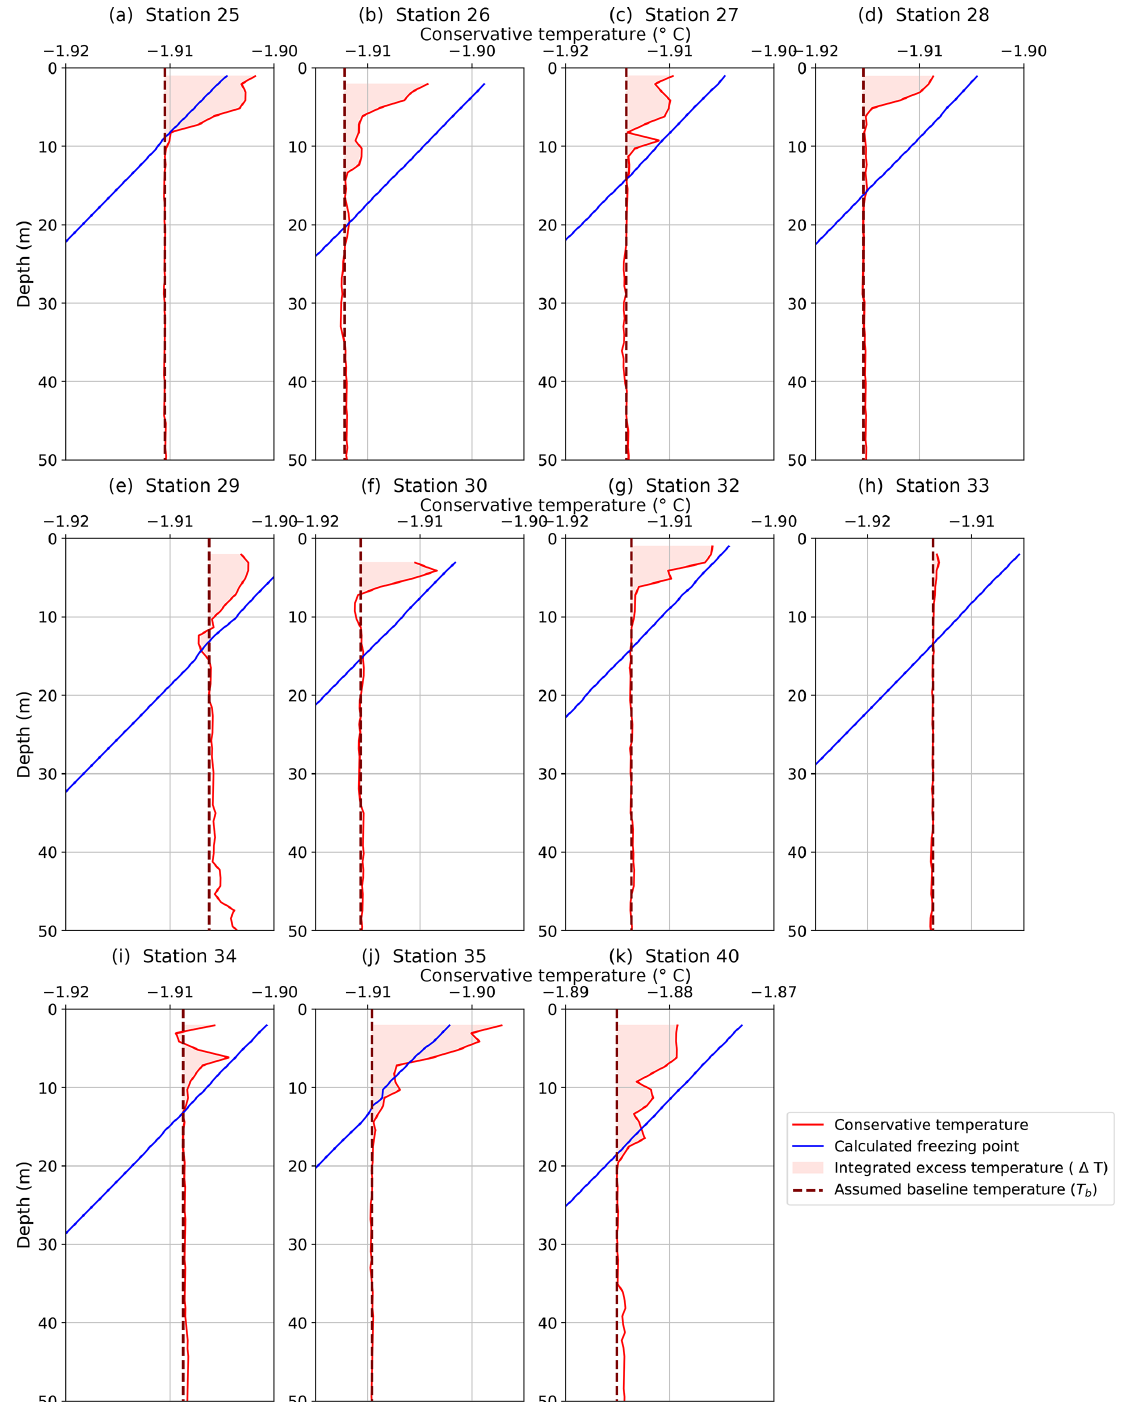
Figure 4. Conservative temperature profiles from CTD downcasts from 11 stations showing temperature and/or salinity anomalies. Plots (a– g, i–k) all show an anomalous temperature bulge. They also show supercooled water at the surface with the exceptions of (a, j) . All of the plots have an x axis representing a 0.02 ◦ C change. Profiles (a–j) are from TNBP, and (k) is from